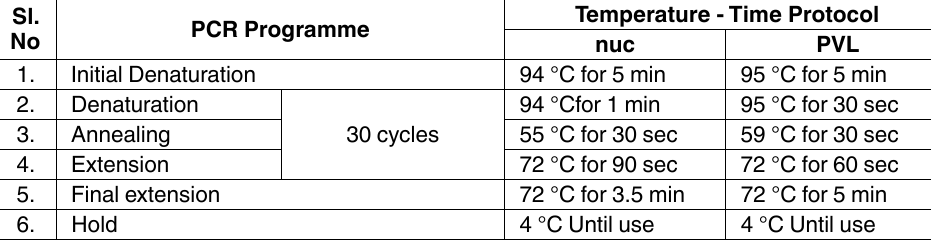
table 3. PCR protocol for the amplification of virulence genes of S. aureus